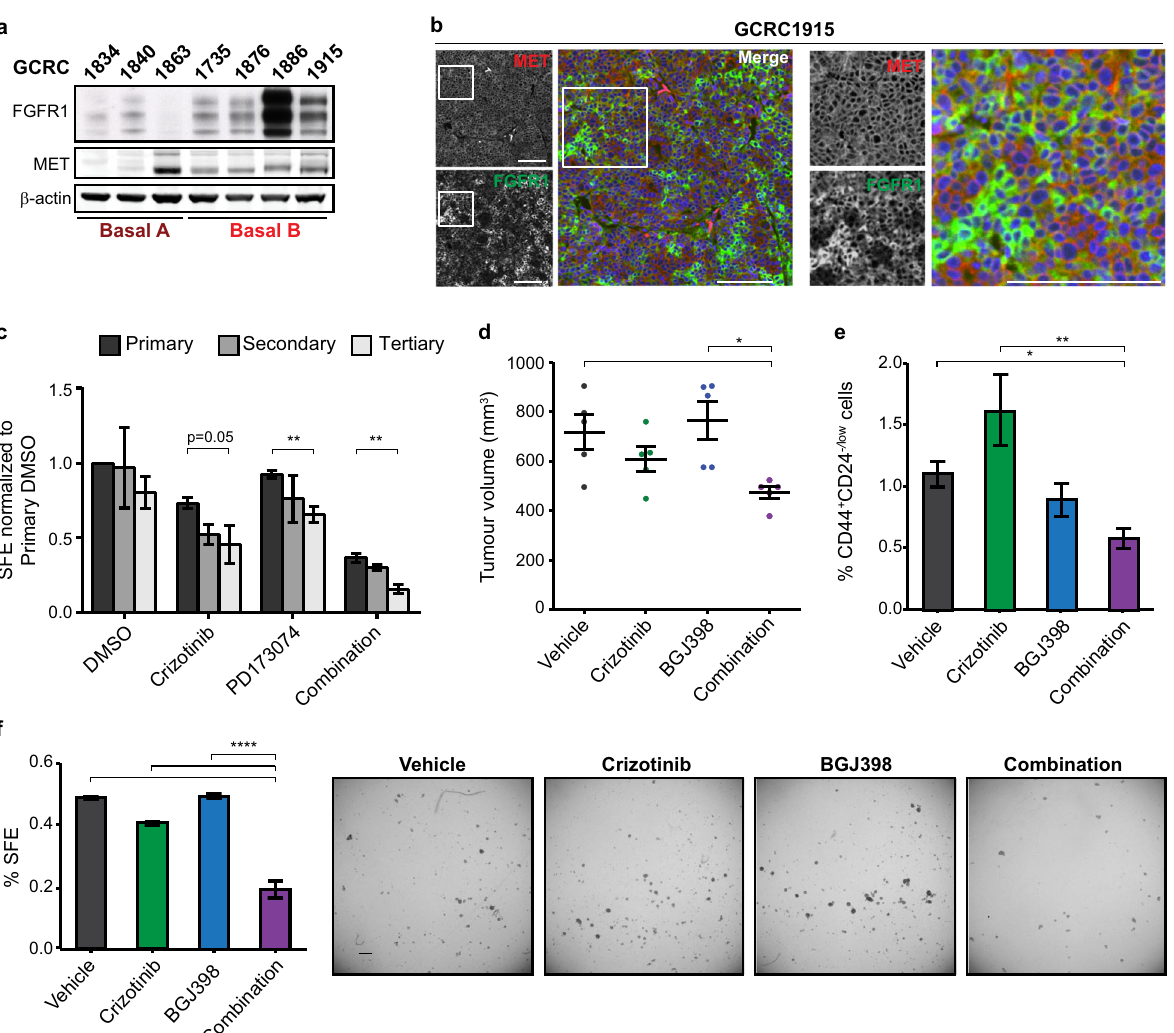
Fig. 7 Basal B TNBC PDX tumours that co-express MET and FGFR1 are susceptible to TIC depletion via dual inhibition of MET and FGFR signalling. a Cell lysates were generated from mammary PDX tumour fragments and used to determine MET and FGFR1 expression